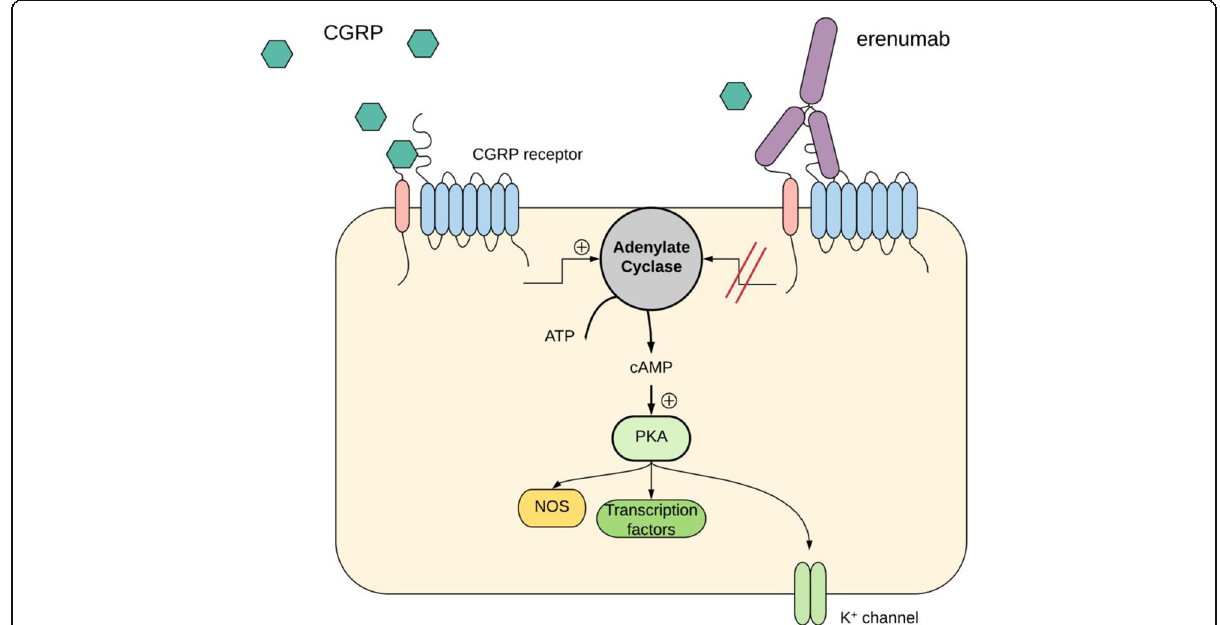
Fig. 1 Intracellular signaling pathways of calcitonin gene-related peptide receptor activation. One effect of CGRP receptor activation is adenylate cyclase-mediated cyclic adenosine monophosphate (cAMP) elevation, which leads to protein kinase A (PKA) activation, and activation of multiple targets depending on cell type. Nitric oxide synthesis may be the result of nitric oxide synthase (NOS) phosphorylation, gene transcription changes may be a result of cAMP response element binding protein (CREB) activation, and relaxation of vascular smooth muscle cells is partly a result of ATP-sensitive potassium channels (K+ channels)